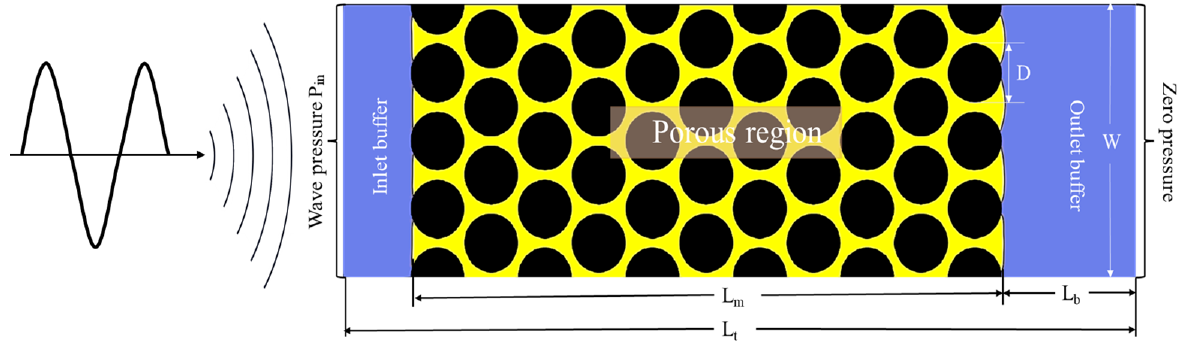
Figure 1. The schematics of the simulation for the cyclic water injection stimulated two-phase displacements in porous media. The computational domain and initial fluid distributions.